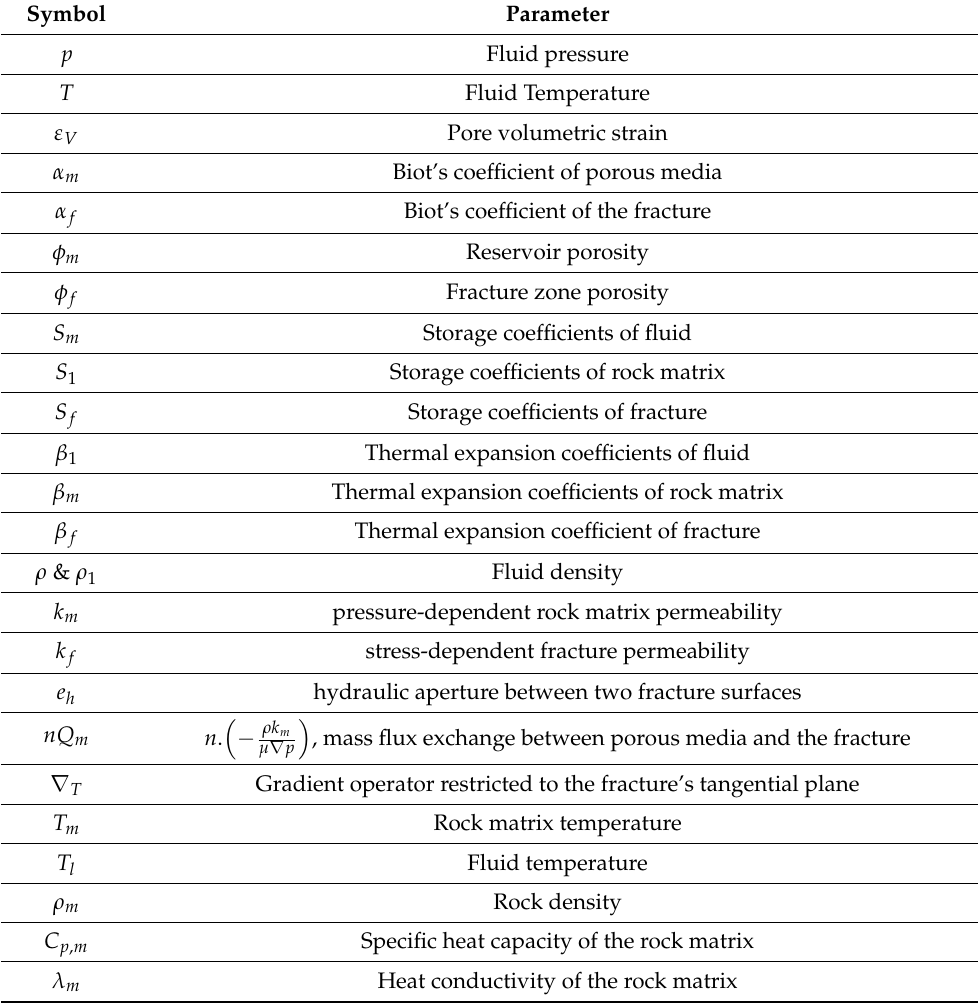
Table A1. List of